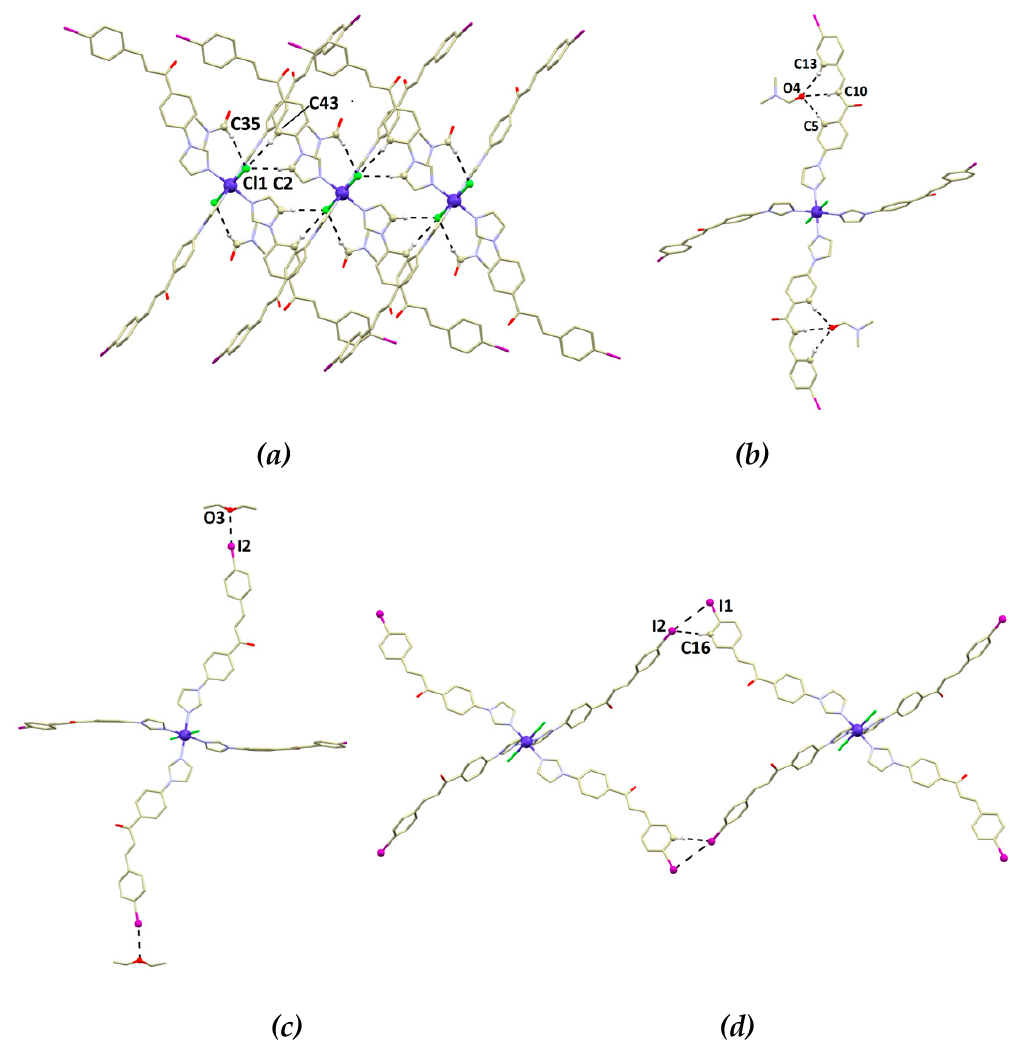
Figure 3. A perspective view on the non-covalent interactions in 1b. ( a ) Supramolecular chain formed by C − H···Cl hydrogen bonding: d (C2···Cl1) = 3.466(5) Å, d (C35···Cl1) = 3.807(4) Å, d (C43···Cl1)